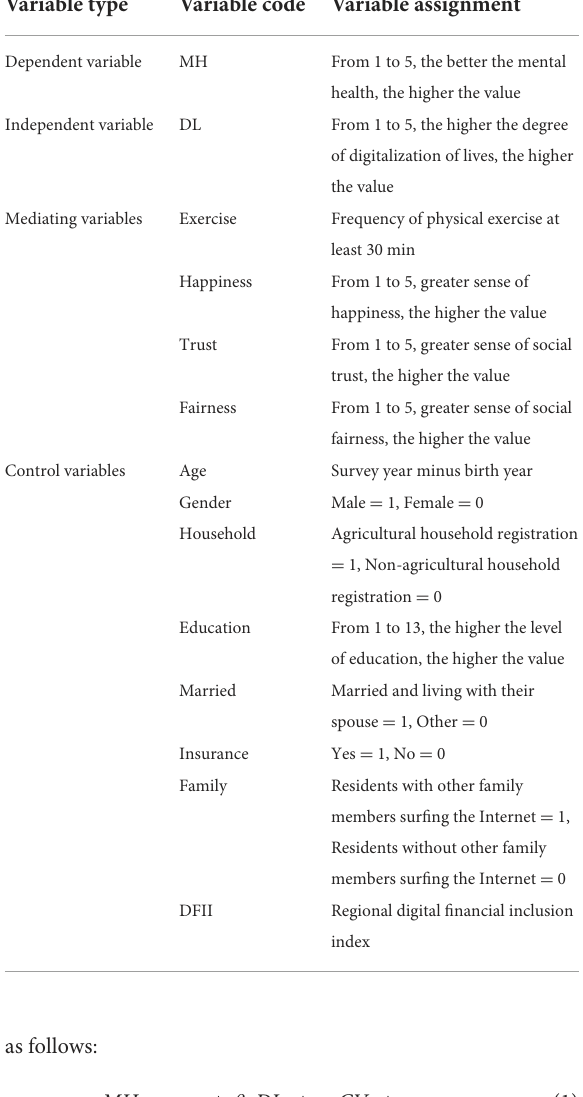
TABLE 1 Variable definition and